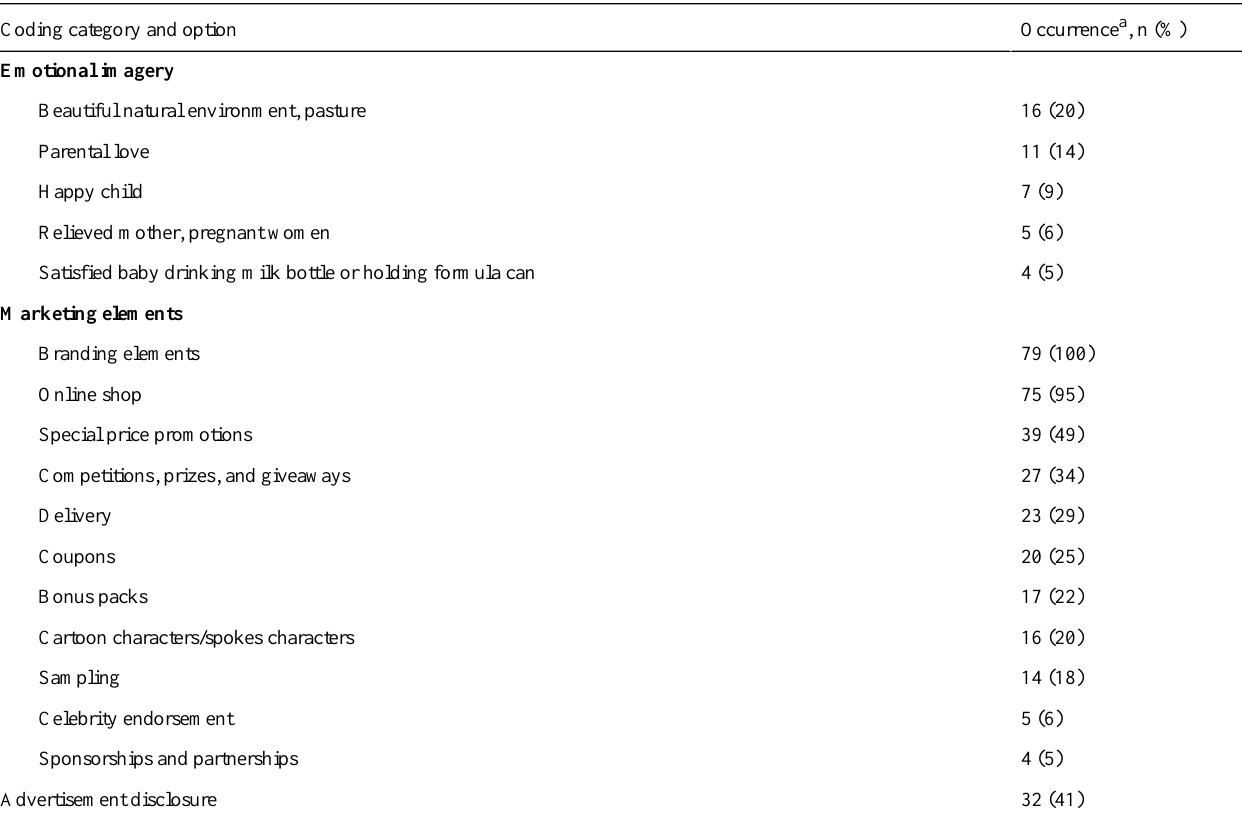
Table 2. Emotional imagery, marketing elements, and advertisement disclosure presented in 79 milk formula brand variant ads.